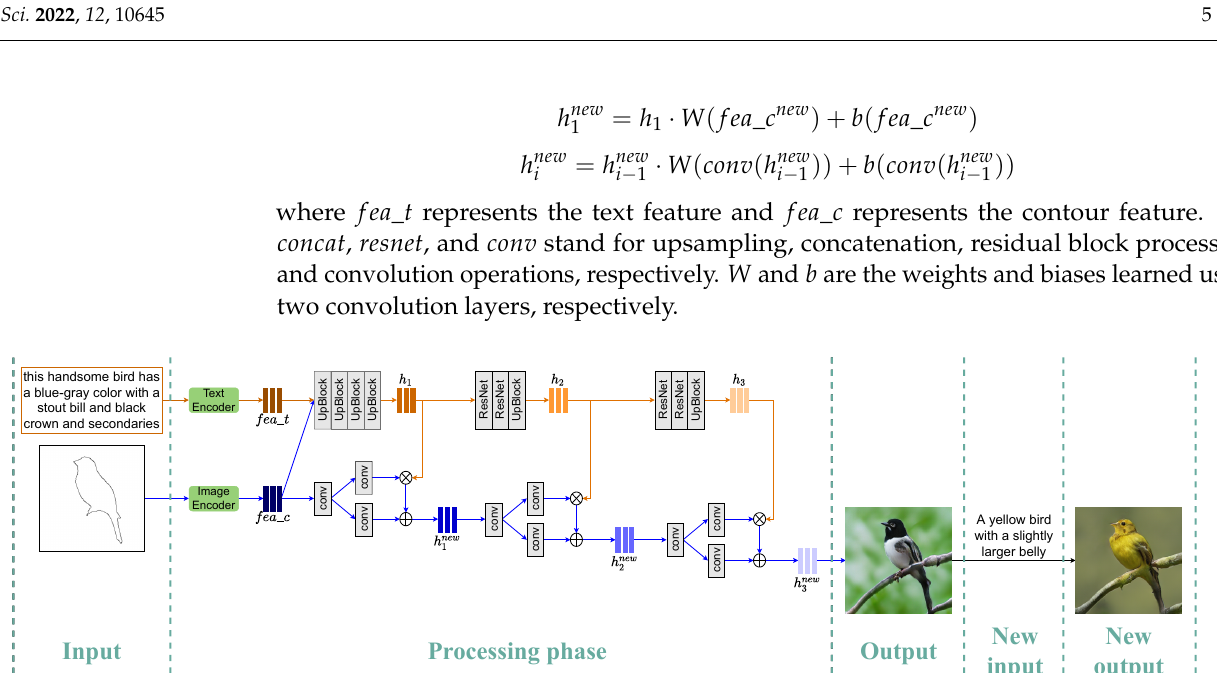
Figure 2. The basic structure of synthesizing images based on text and contour is shown in the figure above. Through continuous processing and fusion of text and contour information, the entire structure finally synthesizes the image result that not only conforms to the text’s semantic information but also maintains the contour shape. The image manipulation based on the new text is shown on the far right. The image manipulation result shows that the new text’s semantic information is well reflected in the previously synthesized